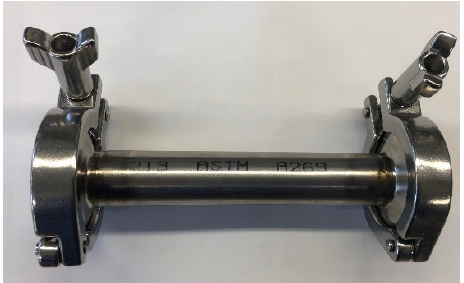
Figure 2. Small-scale stainless-steel reactor for sweet sorghum bagasse (SSB) pretreatment study.